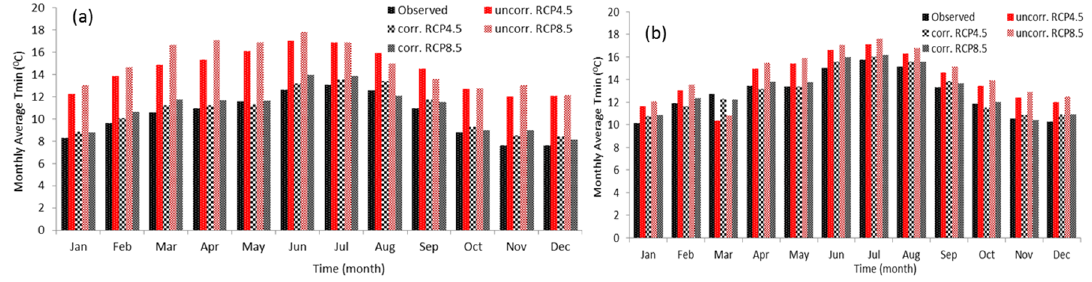
Figure 3. Bias corrected maximum temperature at ( a ) Addis Ababa and at ( b ) Debrazeit stations.